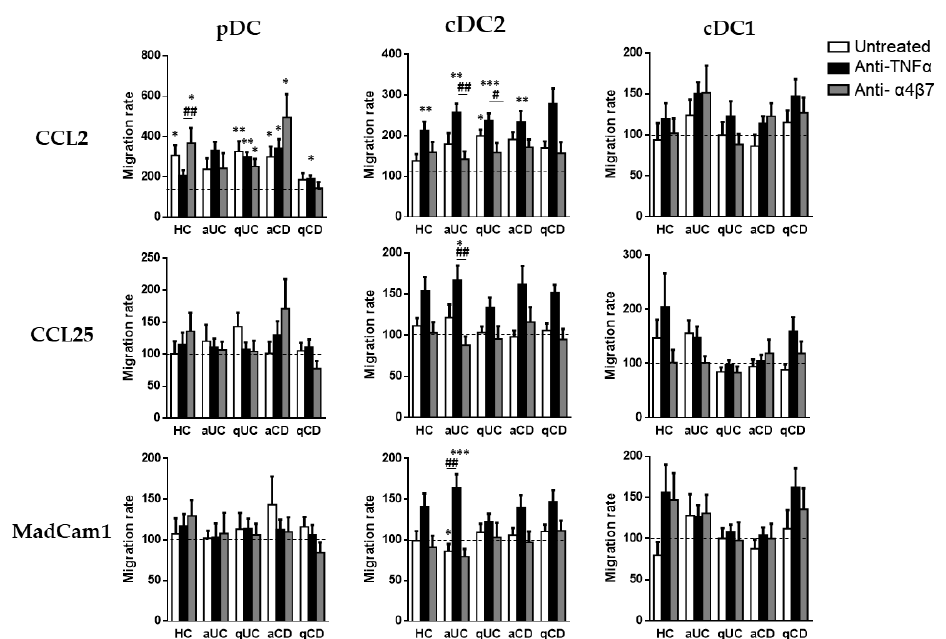
Figure 5. Biological treatments modulate the dendritic cell subset migratory capacity. Peripheral blood mononuclear cells from healthy controls (HCs) and in patients with active ulcerative colitis (aUC), quiescent ulcerative colitis (qUC), active Crohn’s disease (aCD) and quiescent Crohn’s disease (qCD) were allowed to migrate towards gut-homing chemo-attractants including CCL2, CCL25 and MadCam1, following conditioning with anti-TNF drugs (black bars) or the anti- α4β7 drug (grey bars) and compared with non-conditioned cells (white bars). Migrated dendritic cell subsets (DC) including pDCs, cDC2 and cDC1, were identified in Figure 1. All results were relativized with respect to the migration towards a non-supplemented culture medium (basal condition, dotted line) (mean ± SEM n = 13–15). Two-way ANOVA with the subsequent post hoc comparison was performed in order to determine the migration differences within each subset and condition with respect to the basal or spontaneous migration (displayed as *) and to compare the migration within each patient group between each culture condition (displayed as #). p -values < 0.05 were considered significant (* < 0.05, ** < 0.01, *** < 0.001) (# < 0.05, ## < 0.01).